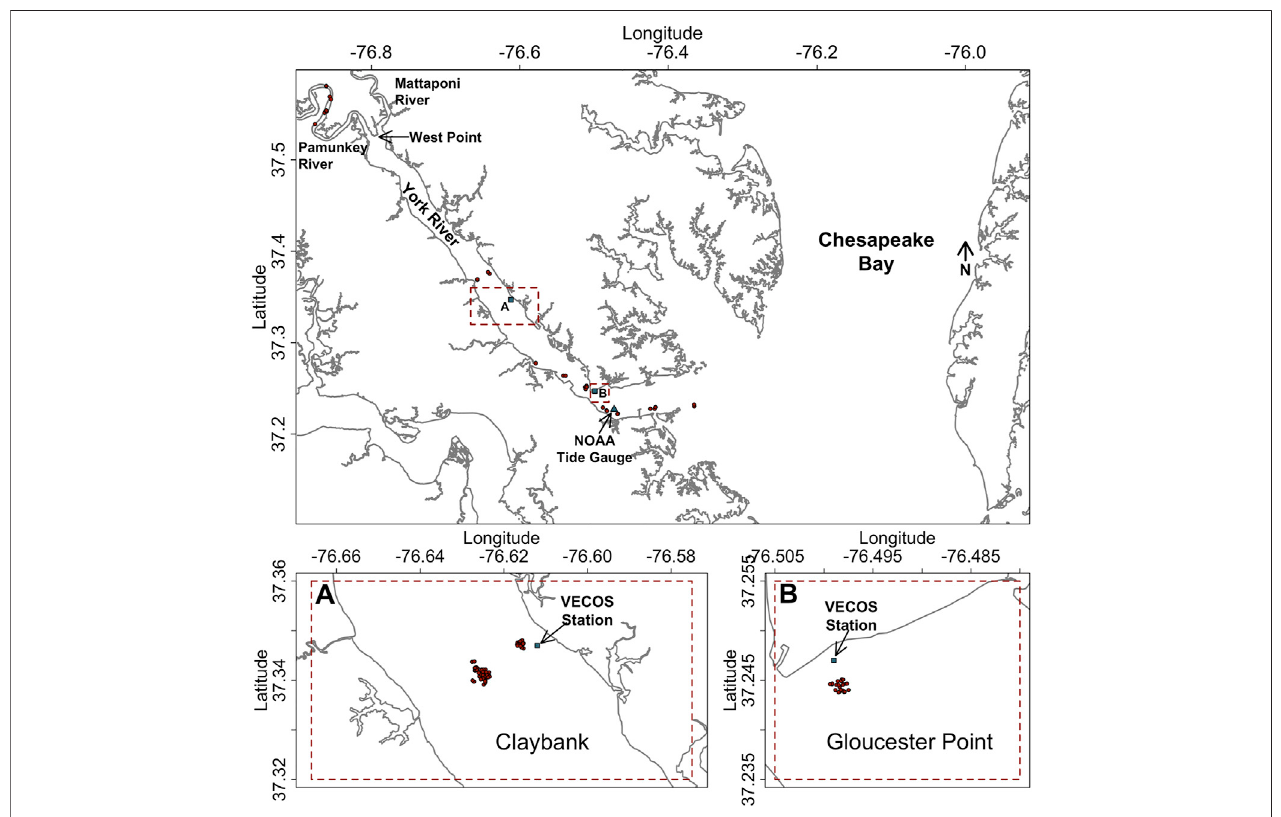
FIGURE 1 | Map of the fi eld setting. Red circles are coring locations. (A) and (B) indicate Claybank and Gloucester Point coring areas.